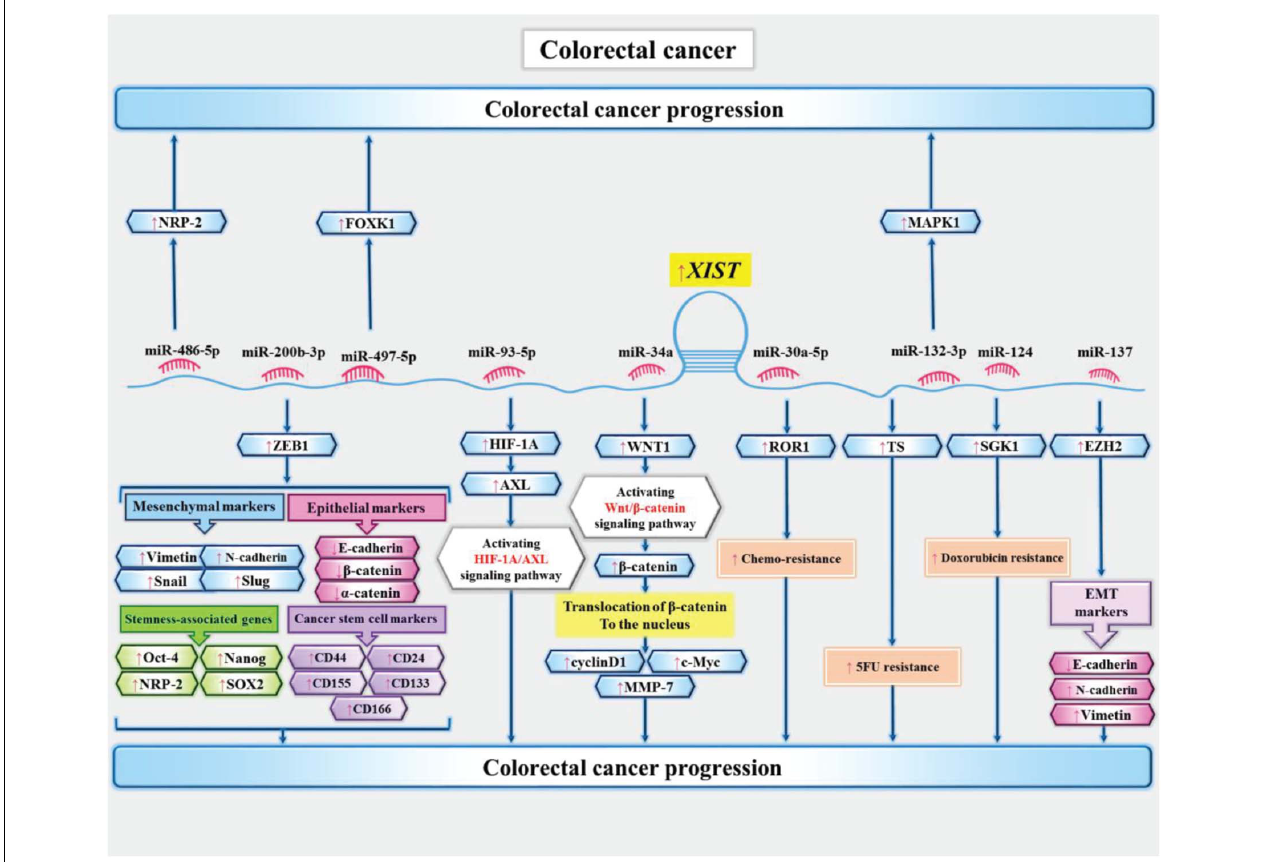
FIGURE 3 | Downstream targets of XIST in colon cancer cells (Chen et al., 2017; Song et al., 2017; Xiao et al., 2017; Liu et al., 2020; Sun et al., 2018; Liu et al., 2019; Wang et al., 2020b). XIST enhances proliferation and epithelial–mesenchymal transition of colon cancer cells via sequestering miR-486-5p and increasing expression neuropilin-2 (Liu et al., 2019). It can also sequester miR-137 and subsequently increase expression of EZH2 to enhance metastatic ability of colon cancer cells (Liu et al., 2018).